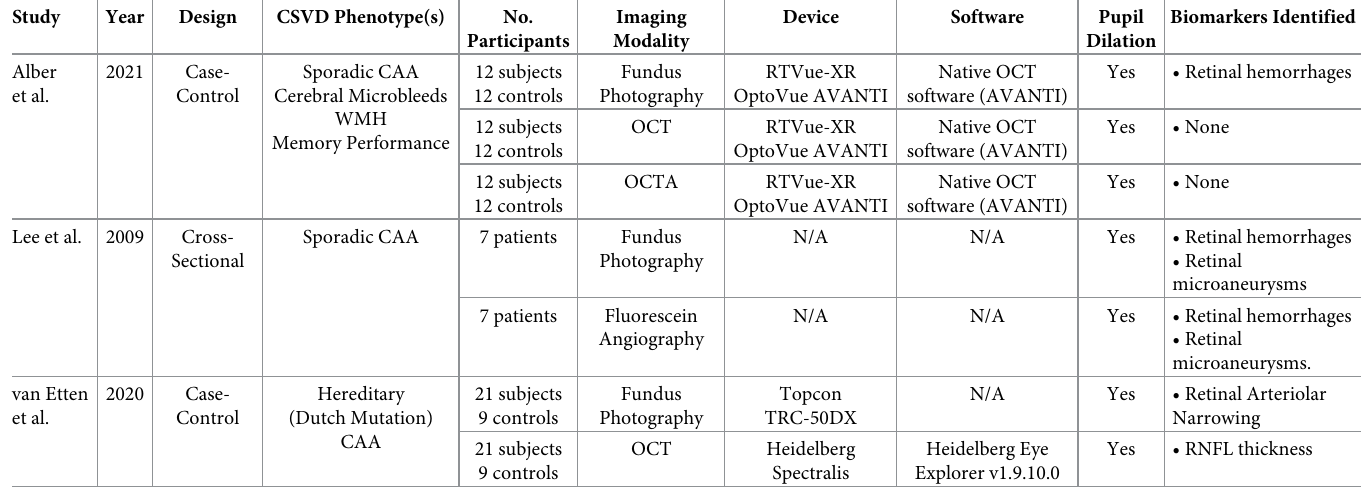
Table 4. Summary of design, patient characteristics, methodology and results for studies of